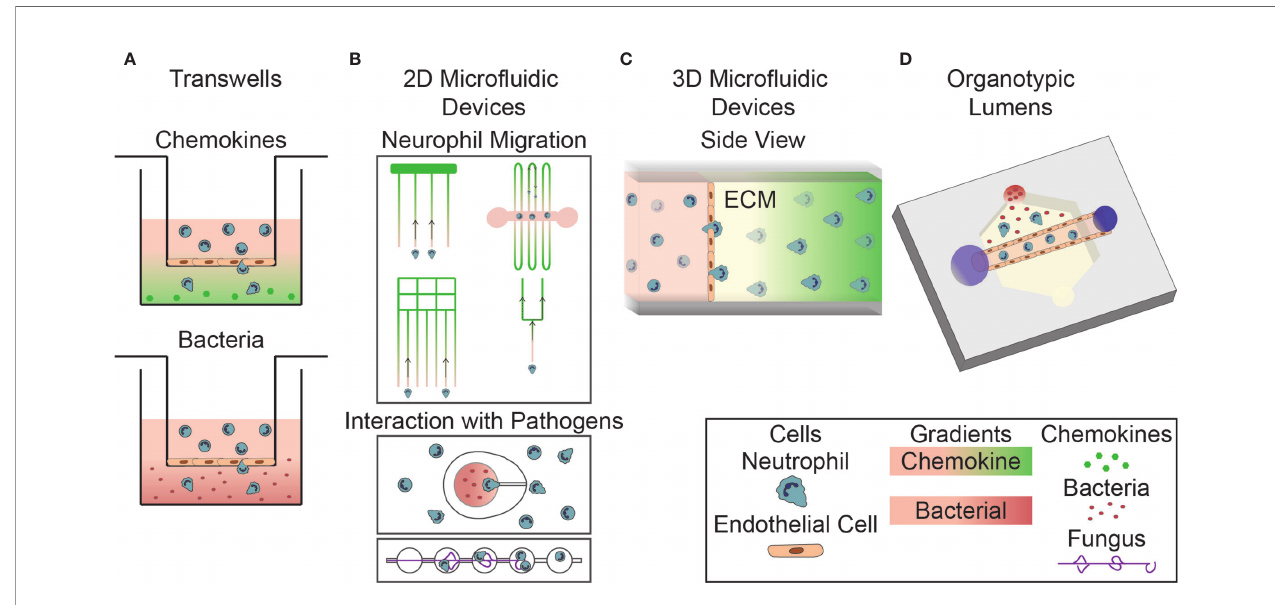
FIGURE 2 | In Vitro Systems for Studying the Neutrophil Response to Infection. (A) Transwell assays, a well-in-well system with a porous membrane divider, are used to investigate neutrophil migration to chemokines (top, green gradient) and bacterial sources (bottom, red gradient) through cellular monolayers. (B) 2D micro fl uidic devices are used to investigate various aspects of neutrophil migration, including neutrophil reverse migration and migration through bifurcations, to soluble chemokines (top). Devices have also been designed to investigate direct interactions between neutrophils and both bacterial and fungal pathogens (bottom). (C) 3D micro fl uidic devices are used to investigate neutrophil migration to soluble chemokines in an extracellular matrix hydrogel following extravasation through an endothelium. Neutrophils migrate through an endothelial monolayer, seeded on the hydrogel, and into the ECM. (D) Organotypic micro fl uidic devices include a model vasculature containing endothelial cells in a relevant lumen geometry. These devices use both chemokines and live pathogens to induce